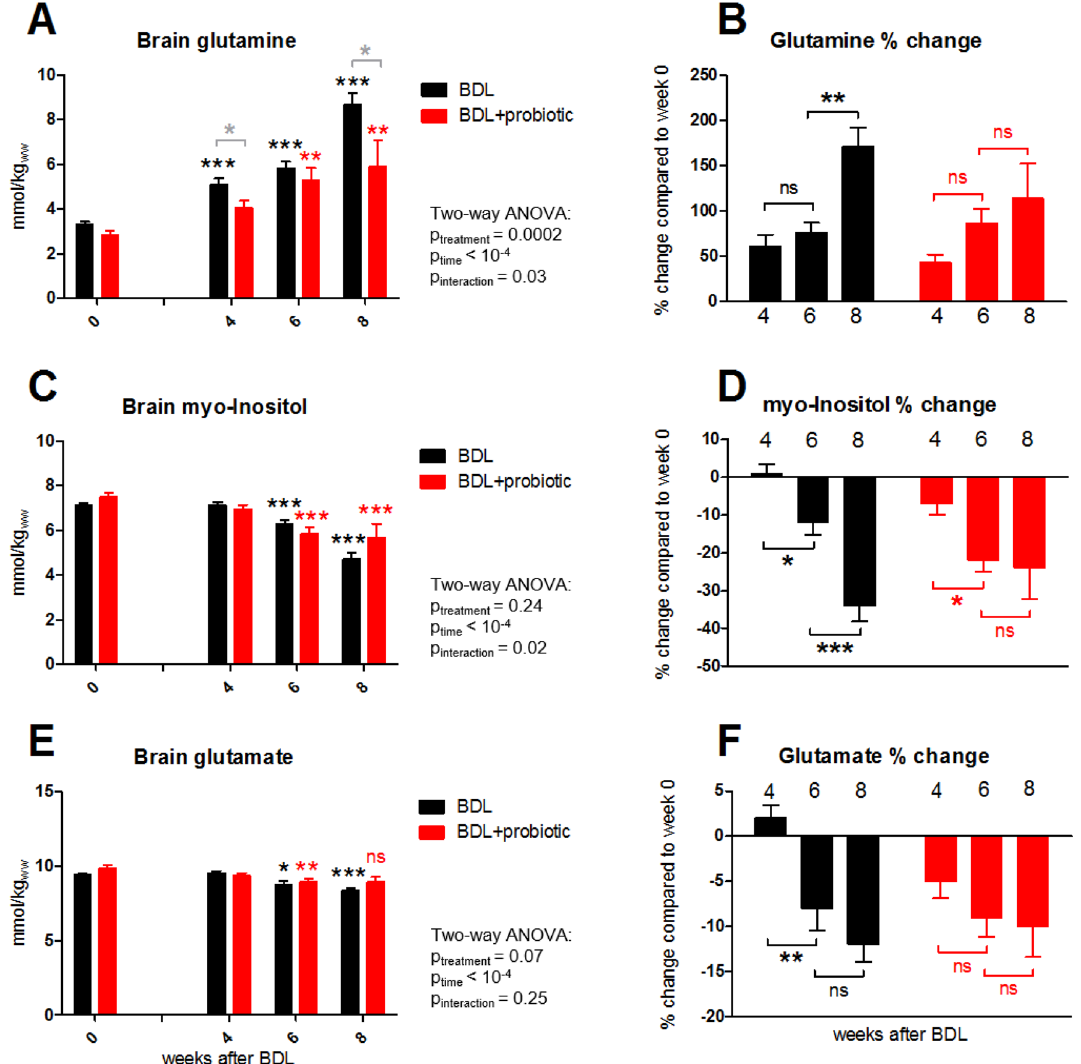
Figure 3. Longitudinal brain Gln, mIns and Glu. Expressed in absolute concentration as mmol/kg ww (mmol per kg wet weight) ( A , C , E ) and % changes as compared to scan 0 ( B , D , F ). Significance (one-way ANOVA with Bonferroni corrections) on graphs ( A , C , E ) in comparison to brain concentration of corresponding metabolite at week 0 (black, red) or between the two groups for a given week (grey). ns non-significant.